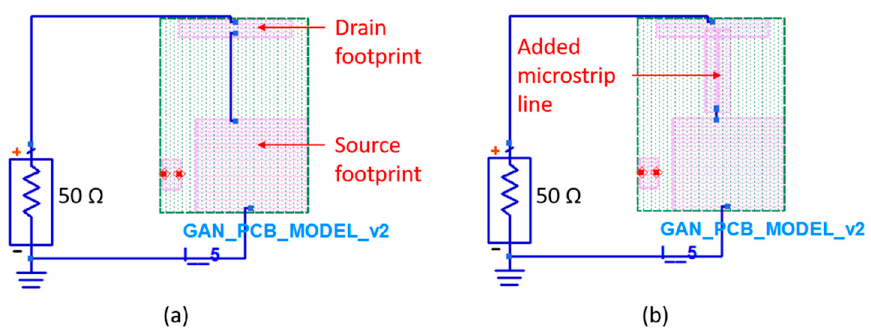
Figure 13. Simulation of the GaN transistor drain–source inductance: ( a ) EM model with device PCB footprint; ( b ) EM model with device PCB footprint and added microstrip line.